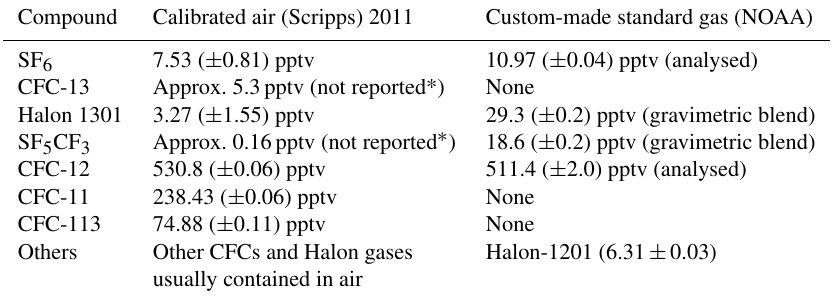
Table 2. Concentrations of compounds in calibrated air standard and custom-made standard gas in parts per trillion by volume (pptv) SIO- 2005 scale.